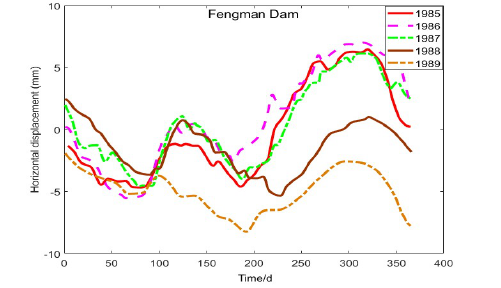
Figure.2 Observed horizontal displacement of the dam crest of Fengman dam from 1985 to 1989